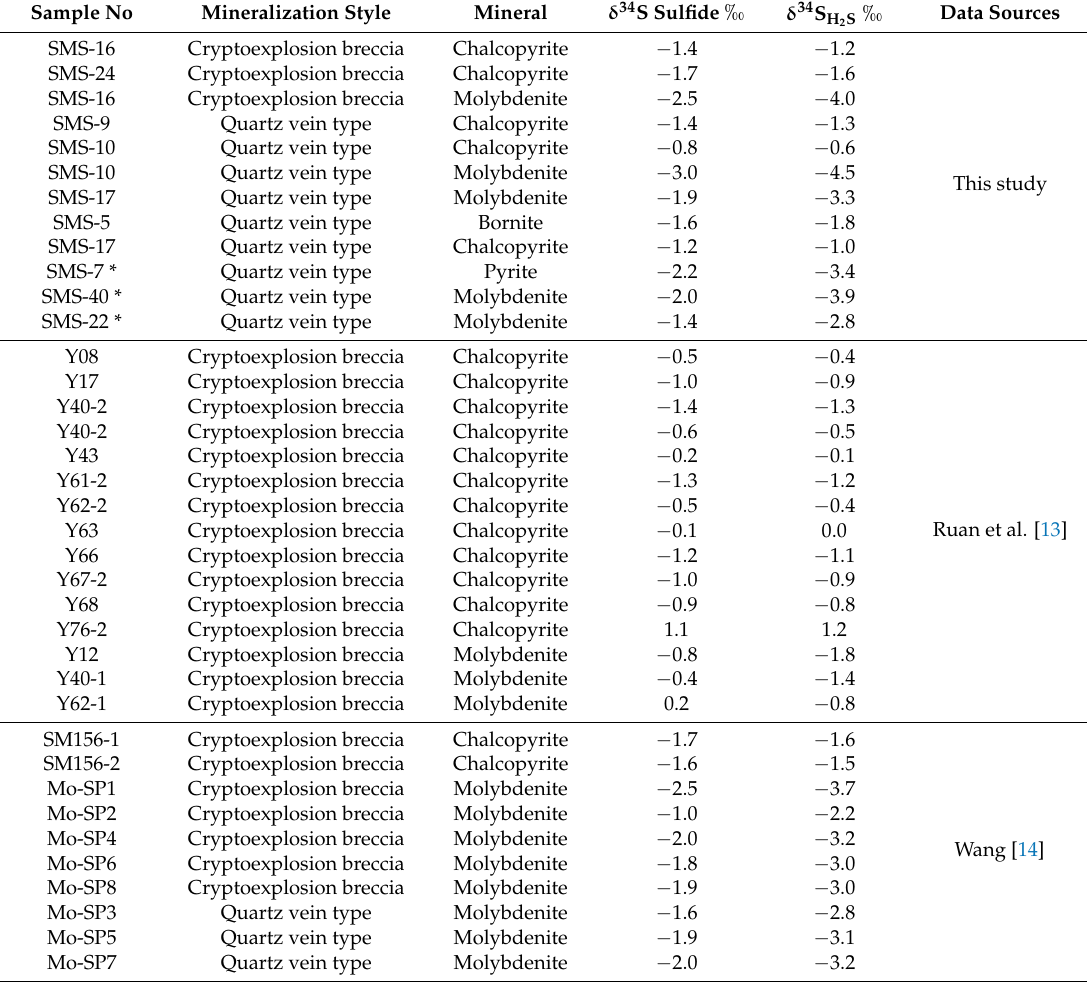
Table 3. Sulfur isotope data from Shimensi (data are relative to